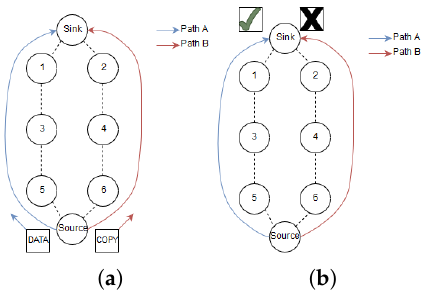
Figure 4. Illustration of Revere Packet Elimination (RPE) step 1 ( a ) and step 2 ( b ).